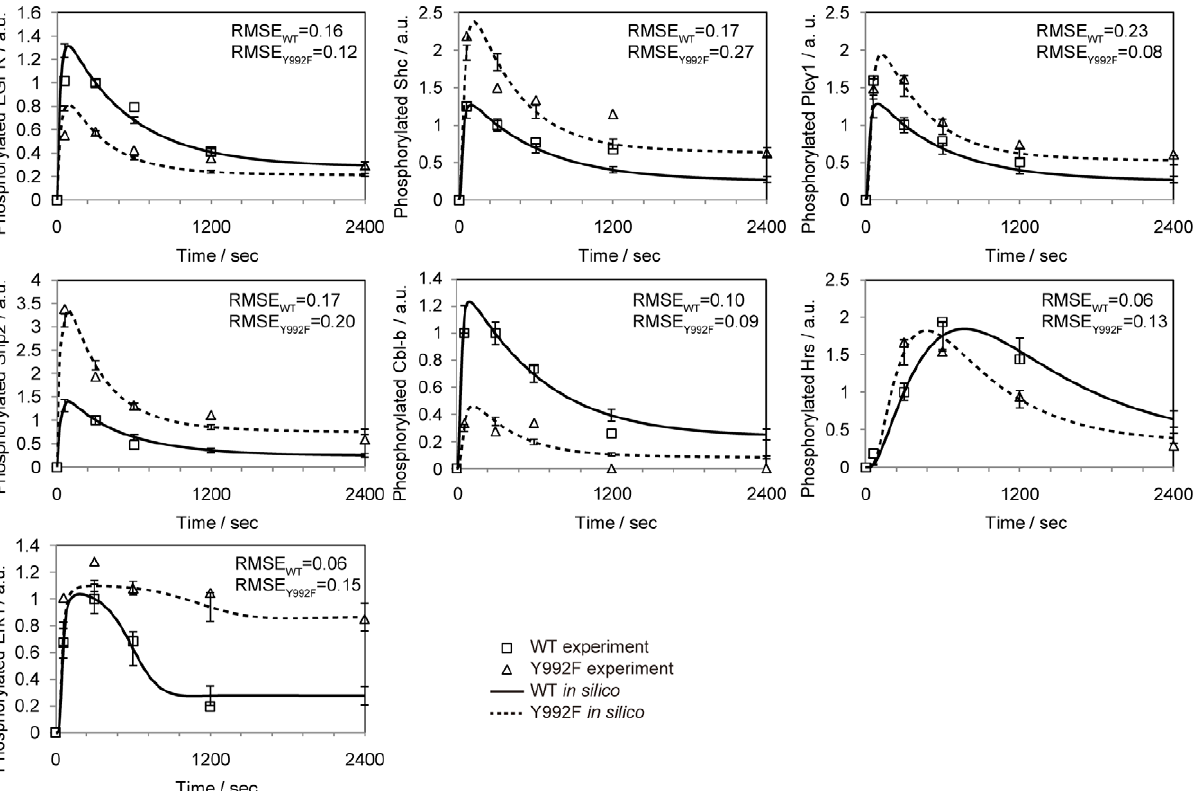
Figure 4. Comparison of simulation results with experimental data. The solid and dashed lines represent the averaged simulation results from the WT and Y992F parameter distributions, respectively. The squares and triangles represent the normalized experimental data on WT and Y992F, respectively. Root mean square error (RMSE) for each protein is indicated.